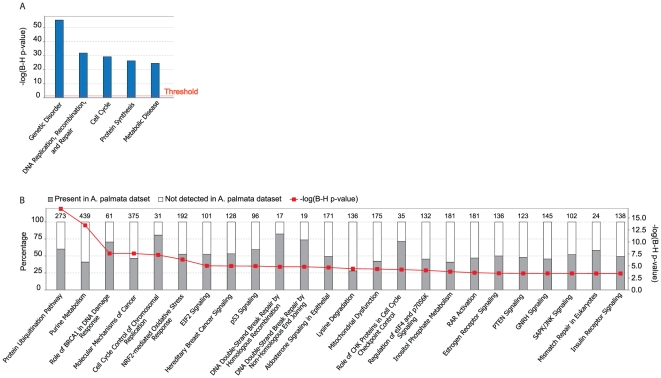
Enrichment analysis highlighted well annotated pathways that are of interest in heat stressed embryos.A) The five most highly enriched functional categories in the A. palmata dataset (the orange line represents the threshold for significance at p<0.05 with FDR adjustment for multiple testing. B) The top canonical pathways from the IPA library of pathways that were most significant to the dataset. The left Y axis shows the percentage of proteins in the pathway that were identified in the A. palmata data (grey bars, note that this is independent of expression levels). The right Y axis shows the corrected –log (p-values) for Fisher's exact test of the probability that the association between the pathway and the data is explained by chance.